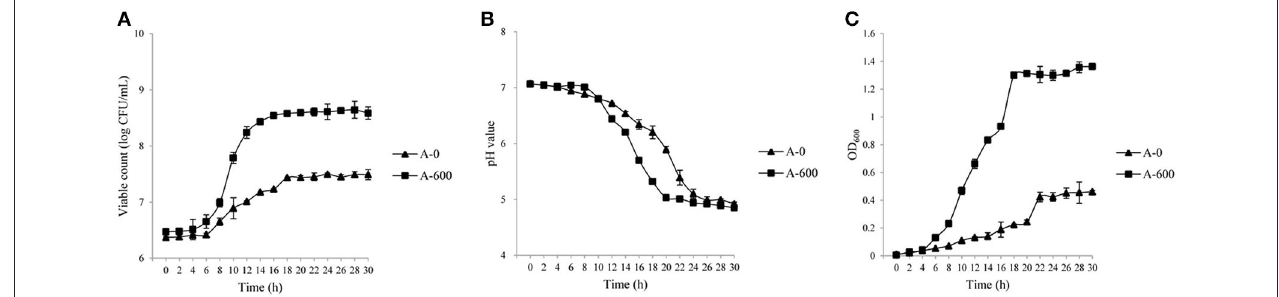
FIGURE 1 | Growth of Lactobacillus casei strains in lactic acid bacteria susceptibility test medium broth (LSM) supplemented with amoxicillin. Changes in the viable counts (A) , pH (B) , and OD 600 (C) were monitored over 30h. The parental and the amoxicillin-resistant (Zhang-A-600) strains are represented by “A-0” and “A-600,” respectively. Error bars represent standard deviation.